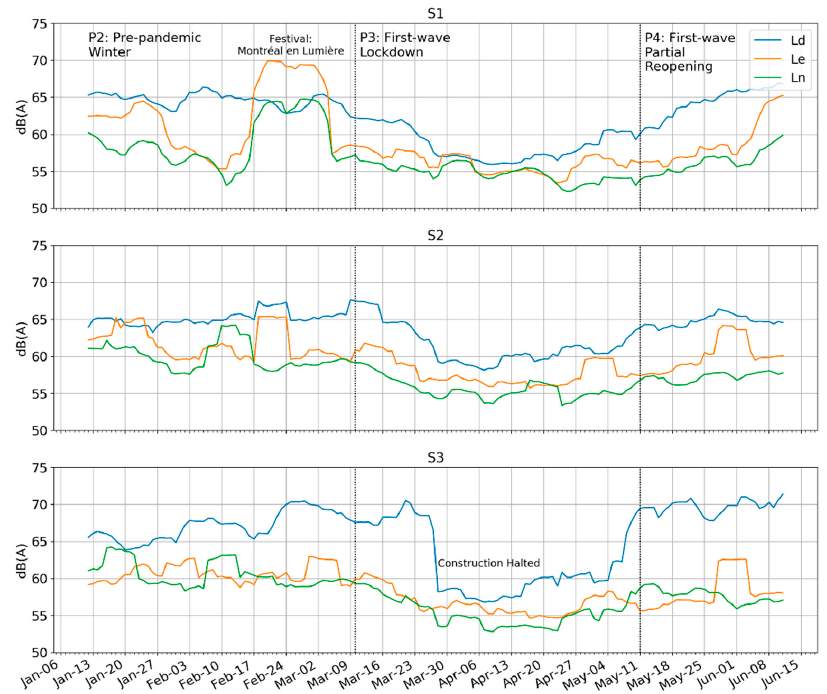
Figure 4. Daily L d , L e , and L n (day, evening, and night) shows a sharper decline during lockdown (P3) in daytime levels compared to the evening and